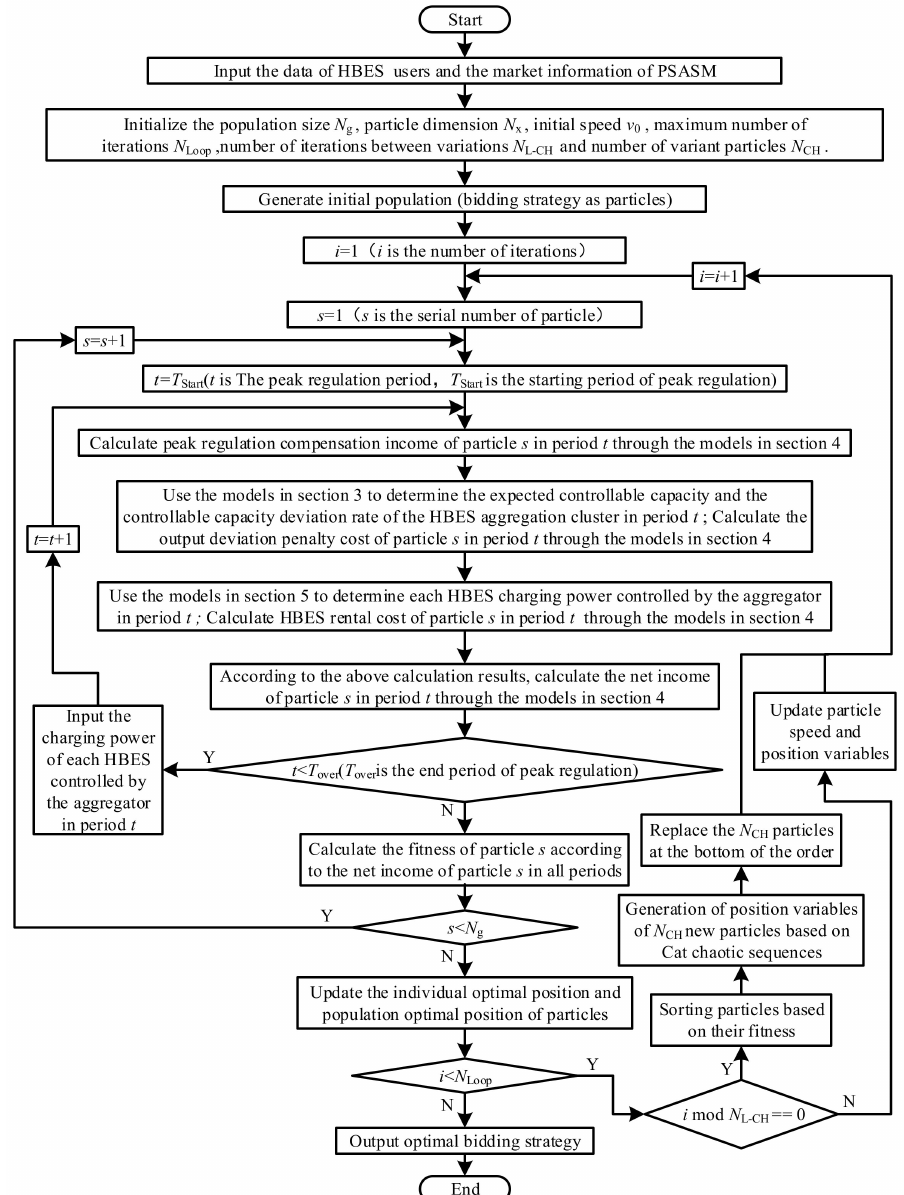
Figure 2. The solution flow chart of the optimal bidding